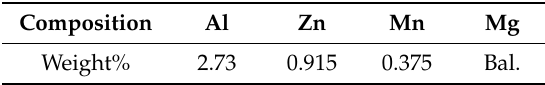
Table 2. Chemical composition of AZ31B rolled sheet